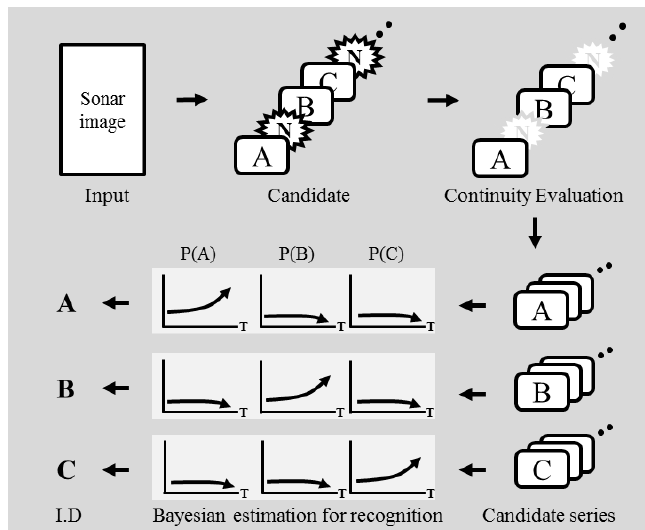
Figure 3. Flowchart of probability-based recognition